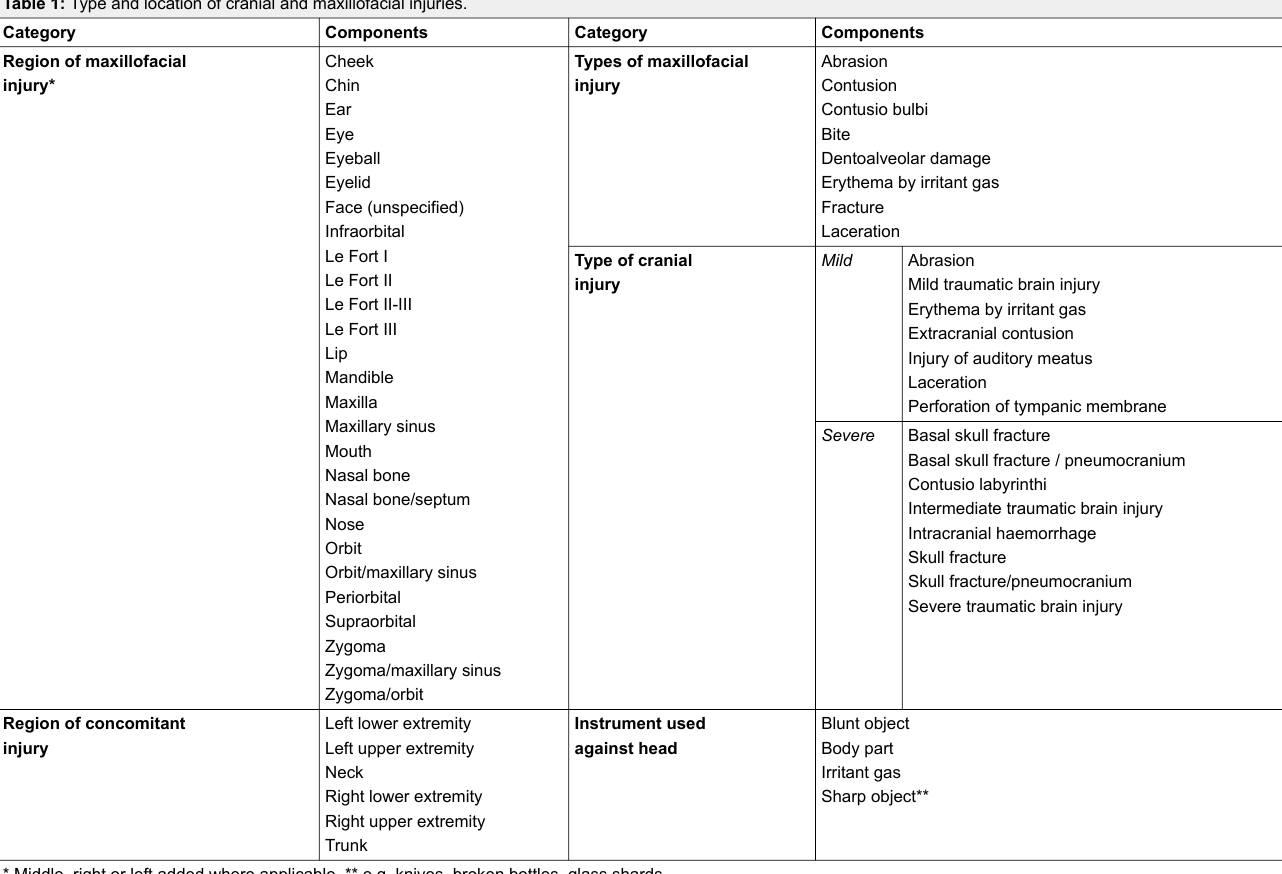
Table 1: Type and location of cranial and maxillofacial